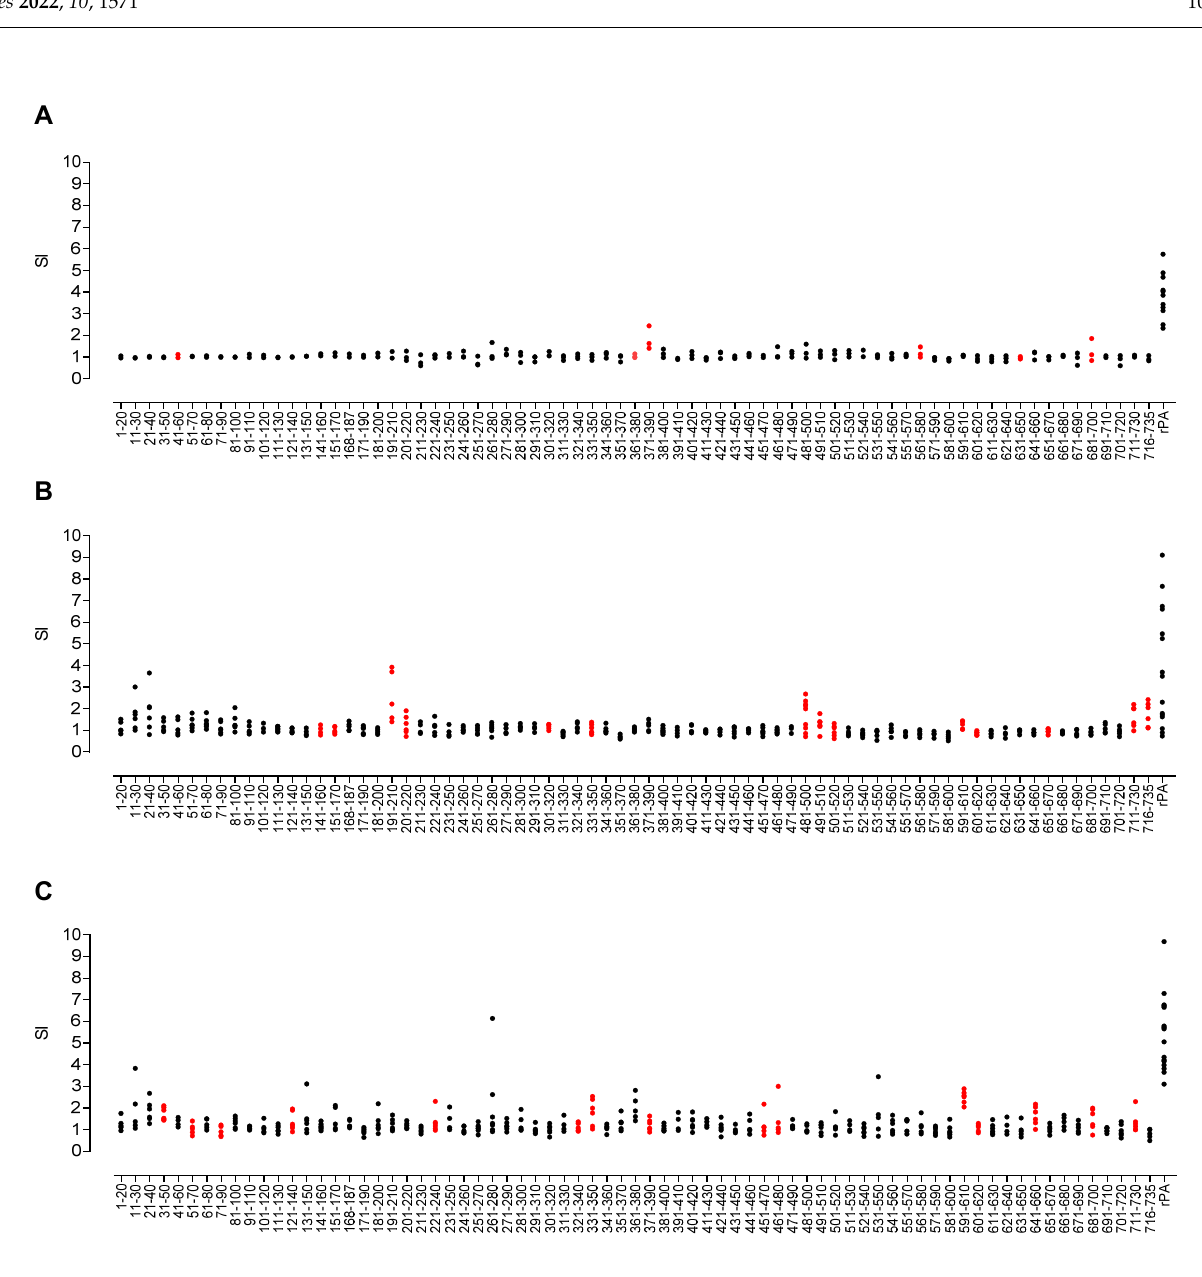
Figure 3. T-cell responses to PA peptides in whole rPA-immunised HLA-DR and HLA-DQ transgenic mice. Groups of HLA transgenic mice were immunised with the whole rPA protein in adjuvant, and the proliferative responses of draining lymph node cells to overlapping synthetic peptides representing the complete PA sequence were determined. Scatter plots show responses of individual mice transgenic for ( A ) HLA-DR1 (n = 3 for each peptide data point, and n = 11 for the rPA data point), ( B ) HLA-DQ8 (n = 6 for each peptide data point, n = 18 for the rPA data point) and ( C ) HLA-DR4 (n = 6 for each peptide data point, and n = 17 for the rPA data point). Data are presented as the SI calculated as the mean CPM of triplicate wells in the presence of peptide divided by the mean CPM in the absence of antigen. Values twice the mean CPM in the absence of antigen were considered positive responses. Confirmed epitopes are highlighted in